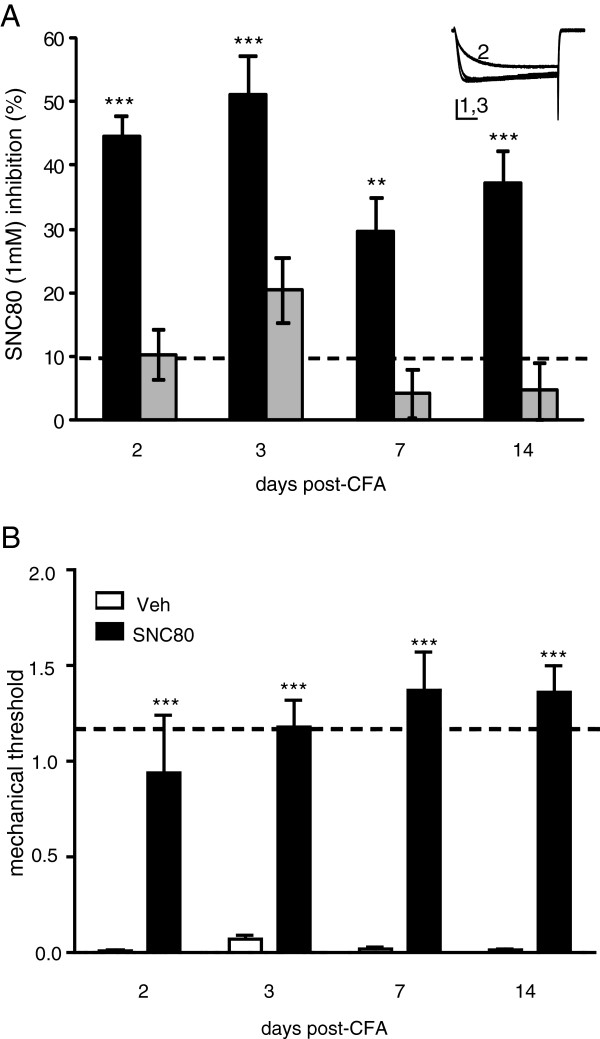
In wildtype mice CFA increased SNC80-Ca2+ channel inhibition and reversed CFA-induced allodynia. A. CFA induced an increase in SNC80-VDCC inhibition in WT DRG neurons from the ipsi-, but not contra-lateral sides to the CFA injection; ANOVA: F (8,78) = 14.86, ** p < 0.01 and *** p < 0.001 vs. basal/naive inhibition, shown by the dashed line. An exemplar current shows VDCCs before (1), during (2) and after (3) SNC80 (1 μM) application, vertical scalebar = 20 ms and horizontal scalebar = 0.5 pA, n = 6–20. B. The effect of SNC80 (10 mg/kg i.p.) or saline was assessed in mice which had been treated with CFA 2, 3, 7 and 14 days prior to the test. Baseline mechanical responses are represented by the dashed line. *** p < 0.001 as determined by 2-way ANOVA with a Holm-Sidak post-hoc analysis (n = 4–8 mice/group).